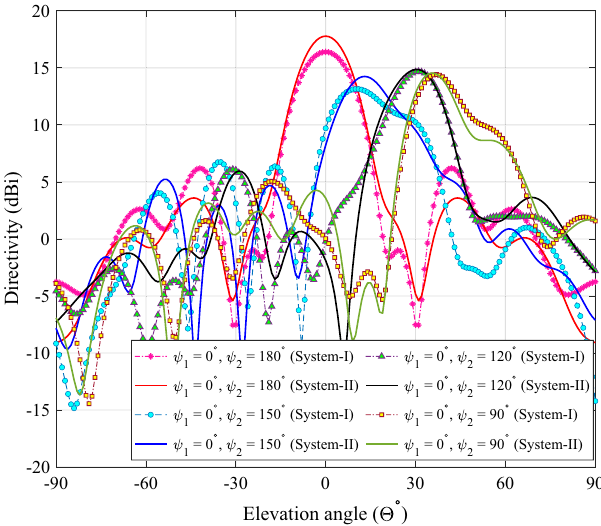
0 and ψ 2 is varied) in =